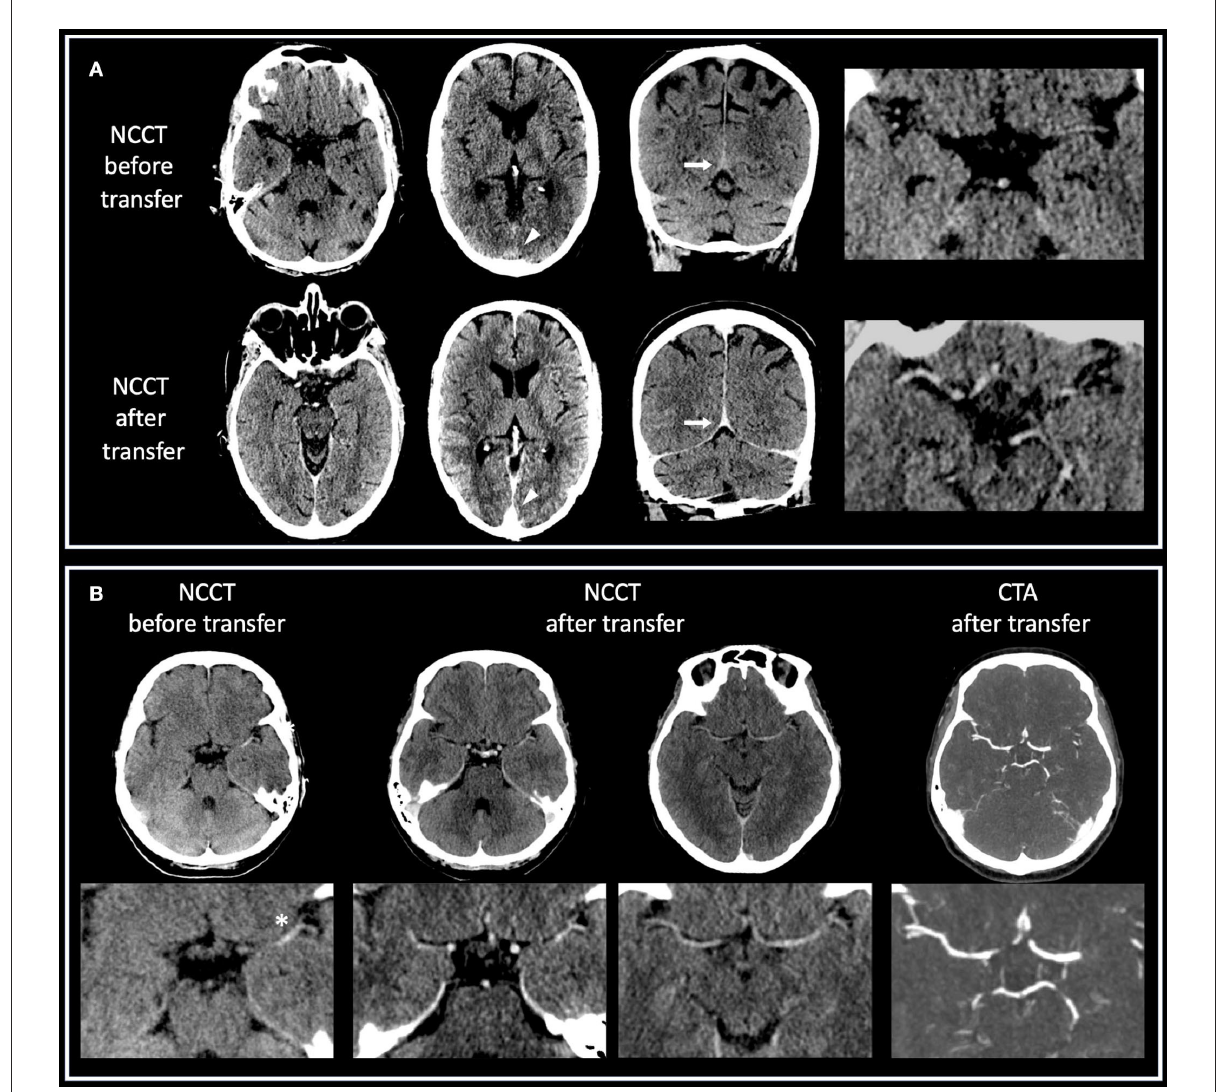
FIGURE1 (A,B) Case examples of non-contrast CT imaging before and after interhospital transfer. (A) Patient with right-sided ICA occlusion who underwent CT imaging at PSC including CTA. Transfer time was 85min, and kidney function was normal. Residual IV iodine contrast produces hyperdense intracranial vessels after the transfer, especially around the Circle of Willis (axial and enlarged views) and in sinuses on axial (arrowheads) and coronal (arrows) views. (B) Patient with left-sided M1 occlusion who underwent CT imaging at PSC including CTA. Transfer time was 90min, and kidney function was normal. Presented are axial and enlarged views. Before transfer, a hyperdense vessel sign (asterisk) due to thrombotic occlusion is clearly visible on non-contrast CT. After transfer, intracranial vessels are hyperdense due to residual IV iodine contrast, which obscures intravascular thrombus. CTA after transfer confirms persistent vessel